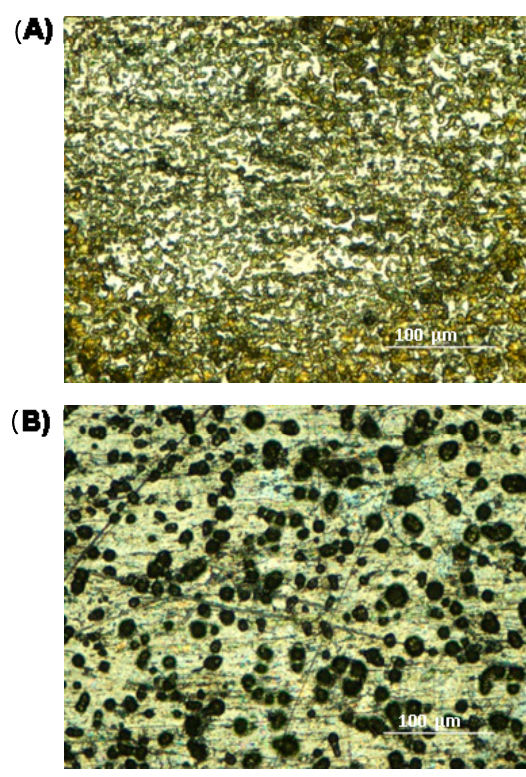
Figure 4. Microscope images of ( A ) CPPA and ( B ) CHCA matrices after mixing with the standard protein solution.